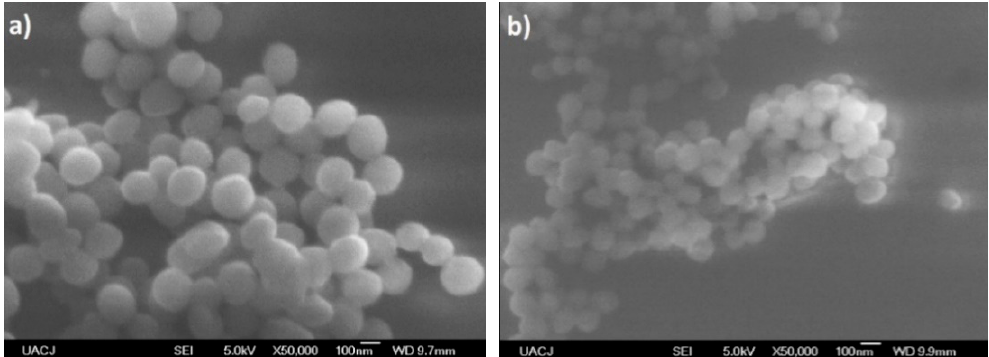
low concentration, ( b ) medium concentration, and (( c ), ( d )) high concentration.